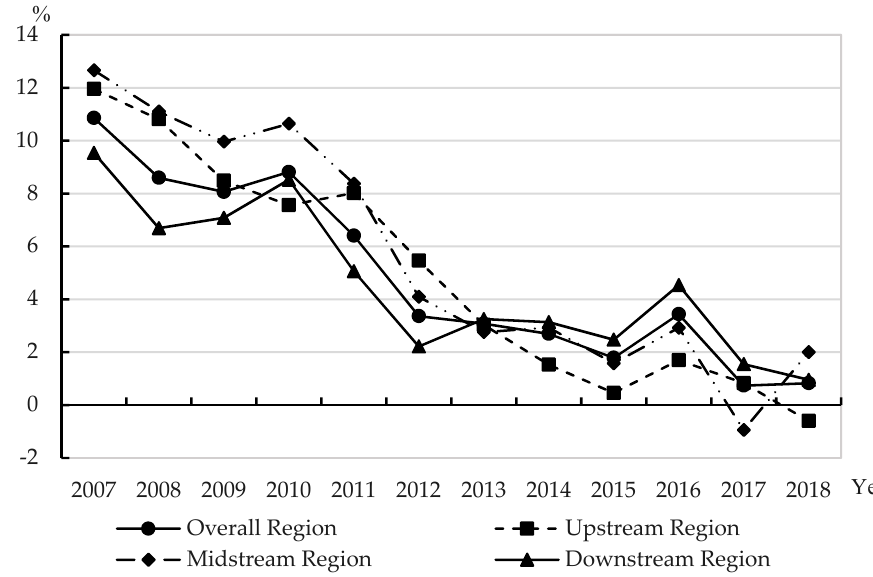
Figure 1. The TFP growth rate ( tfp ) of the Yangtze River Economic Belt from 2007 to 2018. From a region perspective, from 2007 to 2018, the TFP growth rate ( tfp ) of the upstream region, midstream region and downstream region was consistent with that of the overall region and showed a gradually decreasing trend. Since the capital elasticity coefficient α is uniformly 0.7 in this paper, the differences between regions have been reduced to a certain extent, and the actual differences should be larger. From the absolute value from 2007 to 2012, the TFP of the midstream region was the highest, followed by the upstream region, and that of the downstream region was the lowest. From the relative value from 2013 to 2017, the TFP growth rate ( tfp ) of the downstream region was the highest, followed by the midstream region, and that of the upstream region was the lowest. In 2018, the TFP growth rate ( tfp ) of the midstream region ranked first, while that of the upstream region was negative. The difference between the upstream region, midstream region and downstream region shows a trend of first expanding and then narrowing. Summary statistics of tfp in the four regions are shown in Table